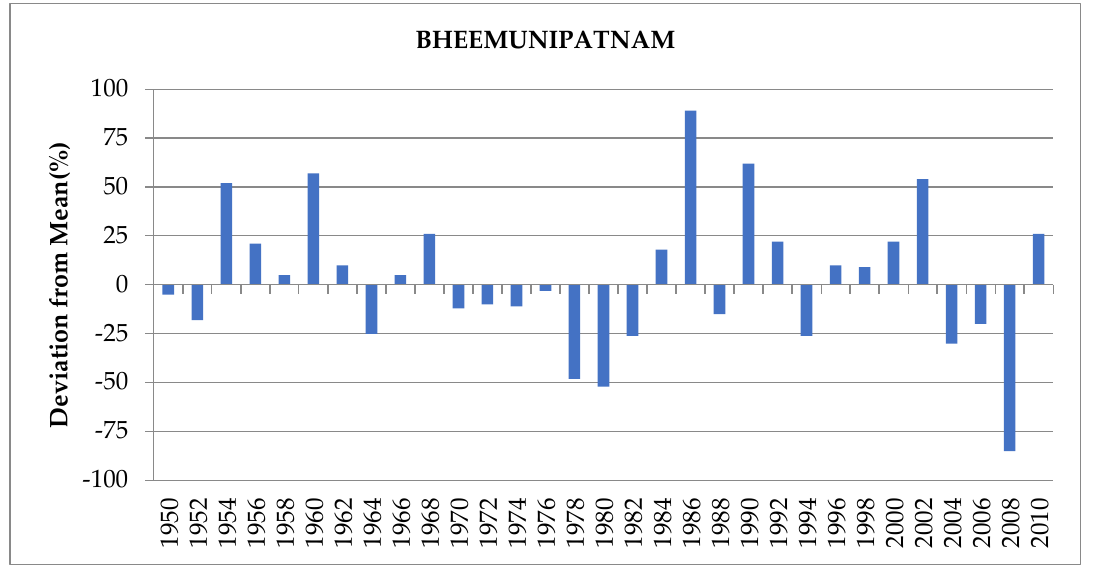
Figure 9. Annual rainfall deviations. Figure 9. Bheemunipatnam.